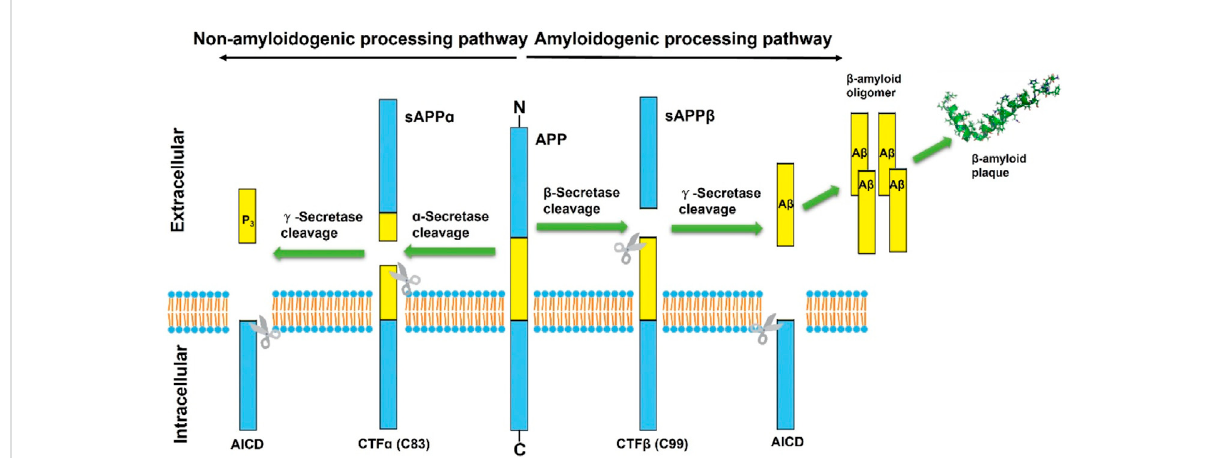
FIGURE 1 Schematic diagram of classical proteolytic processing of amyloid precursor protein (APP) within the non-amyloidogenic and amyloidogenic pathways. The APP is initially cleaved by α and β -secretases, respectively. In the classic amyloidogenic processing pathway, APP is continuously cleaved by β -secretase and γ -secretase, resulting in insoluble A β deposition. In contrast, APP cleaved by α -secretases produces a truncated A β peptide, which does not aggregate and has no